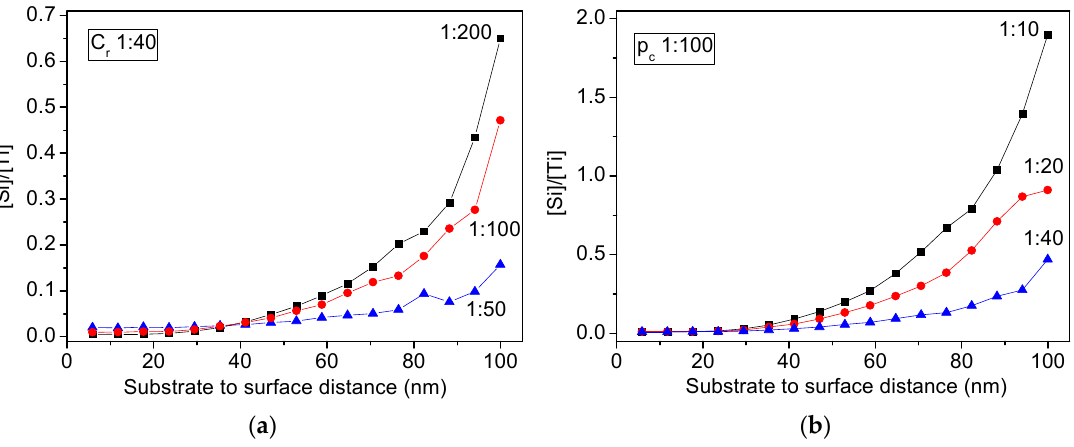
Figure 3. Plot of Si to Ti concentration ([Si]/[Ti]) obtained from simulations for: ( a ) a fixed relative concentration of 1:40 (OrgSil:Ti-alk) and different relative condensation probabilities (OrgSil:Ti-alk) and, ( b ) a fixed relative condensation probability of 1:100 (OrgSil:Ti-alk) and different relative concentrations (OrgSil:Ti-alk).